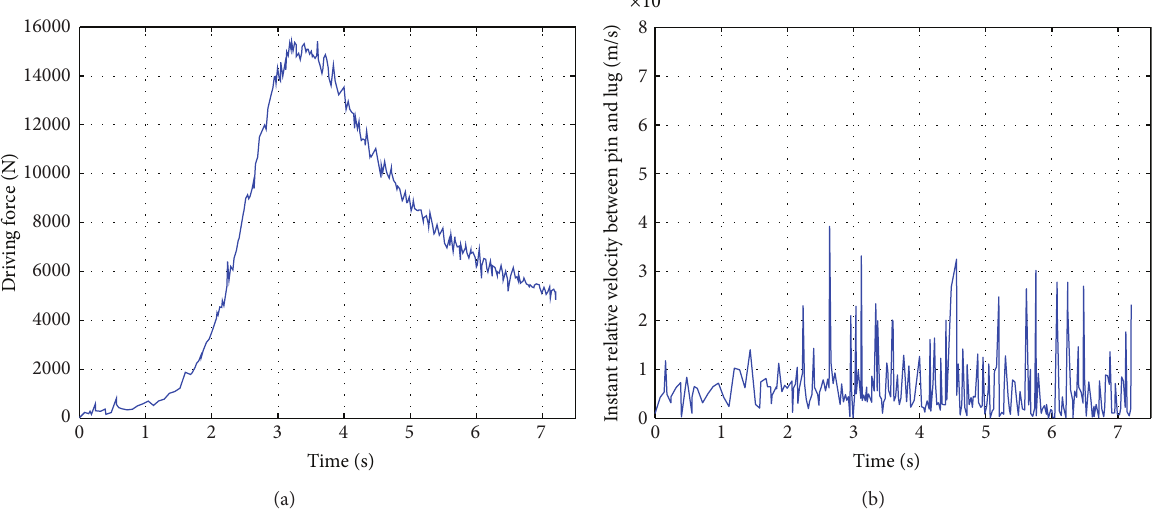
Figure 5: Driving force and instant relative velocity between pin and lug computed by the kinematics model. (a) Driving force curve during the movement; (b) instant relative velocity curve during the movement.